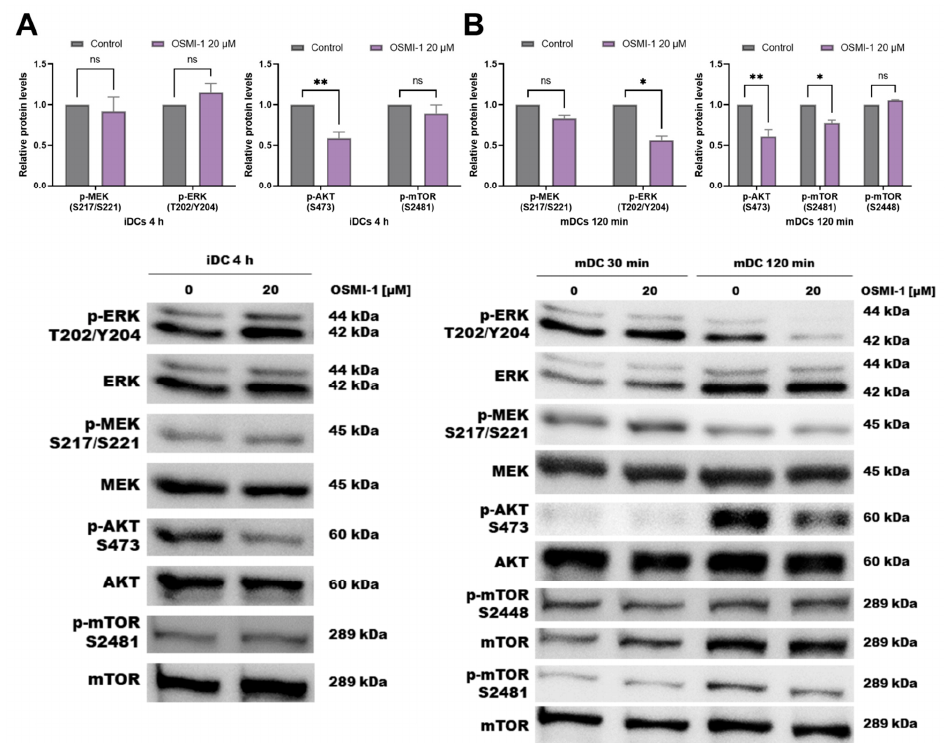
Figure 2. Characterisation of mTOR/AKT and MEK/ERK signalling pathways in the presence of OSMI-1. Representative immunoblots show the expression of phosphorylated and total ERK, MEK, AKT and mTOR in untreated or OSMI-1 treated immature ( A ) and mature moDCs ( B ) (3 different donors). The results in charts are presented as a ratio of phosphorylated/total protein levels normalized to untreated moDCs ± SD. Statistical significance between individual pairs was calculated using ANOVA; p -value < 0.05 was considered statistically significant (* p < 0.05; ** p < 0.01; ns, nonsignificant). iDCs, immature moDCs; mDCs, mature moDCs.